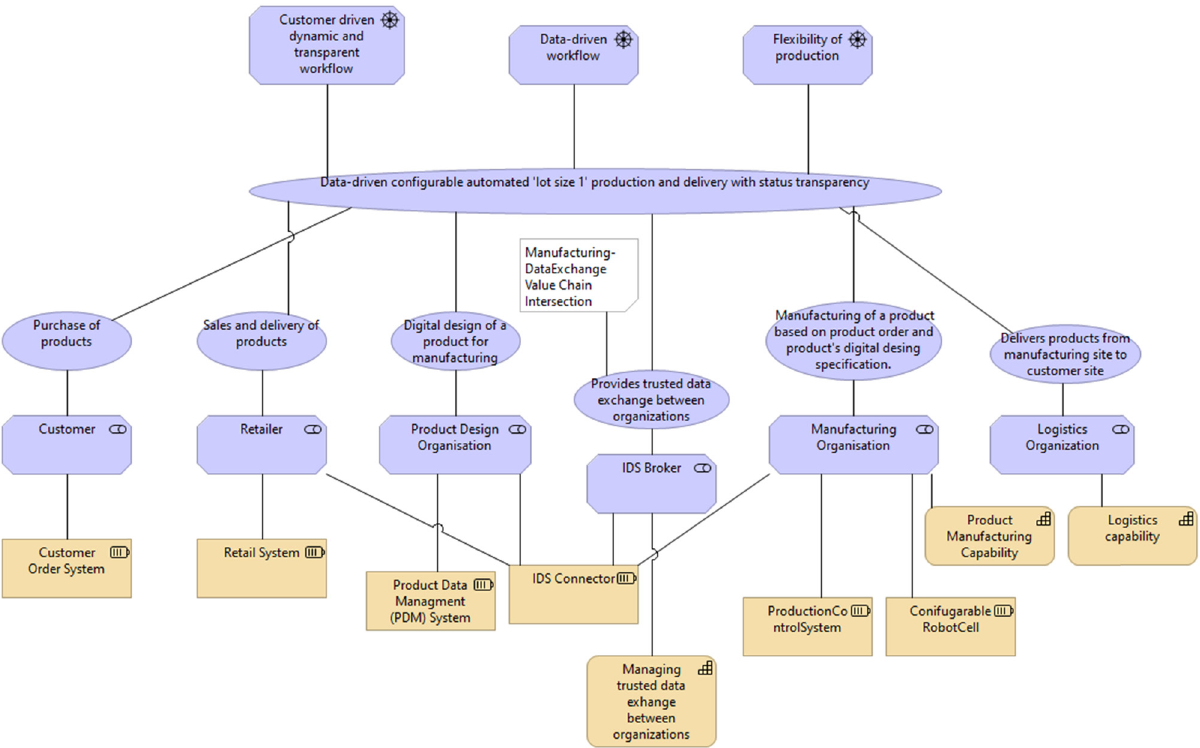
Figure 2: The general architectural context for MaaS as an ArchiMate model